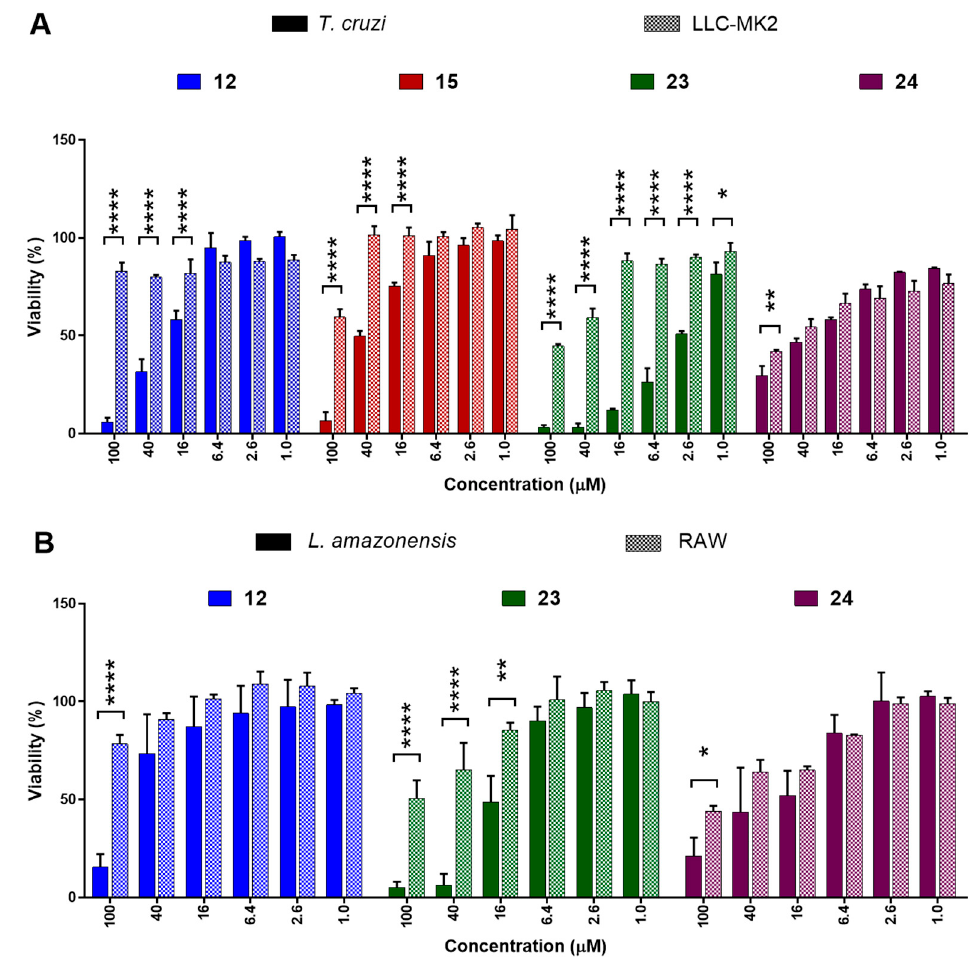
Figure 3. Comparison between the effects of treatment with 1,2,4-oxadiazoles against intracellular amastigote and host cell growth. ( A ) Compounds 14 , 17 , 25 , and 26 against T. cruzi and LLC-MK2 cells. ( B ) Compounds 14 , 25 , and 26 against L. amazonensis and RAW 264.7 cells. * = p < 0.05; ** = p < 0.01; **** = p <